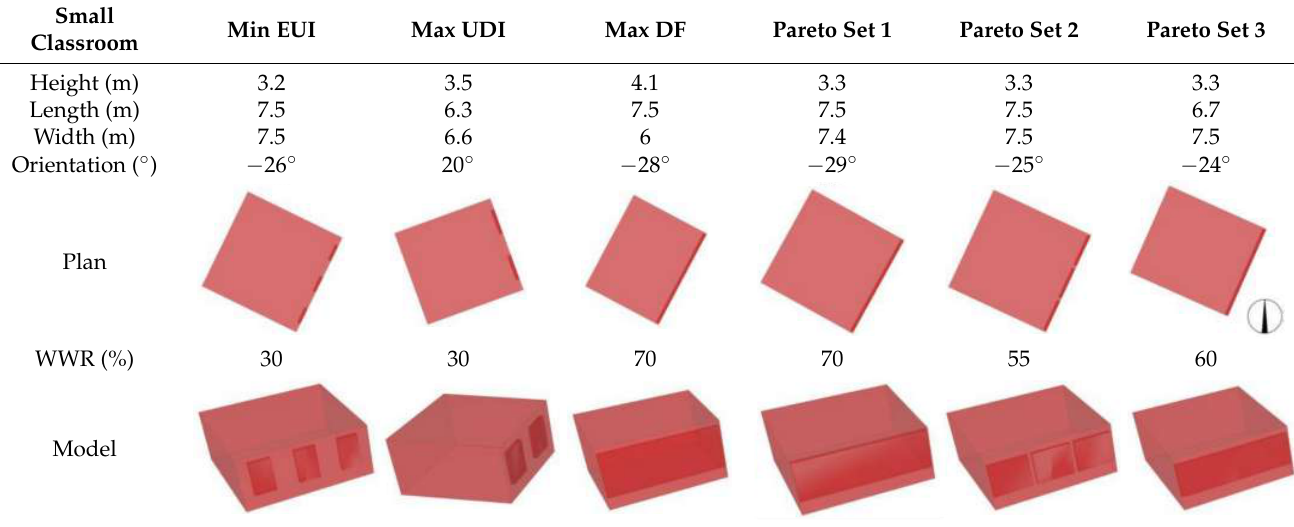
Table 10. Genomes in detail and phenotype output for small-sized classrooms with east facade